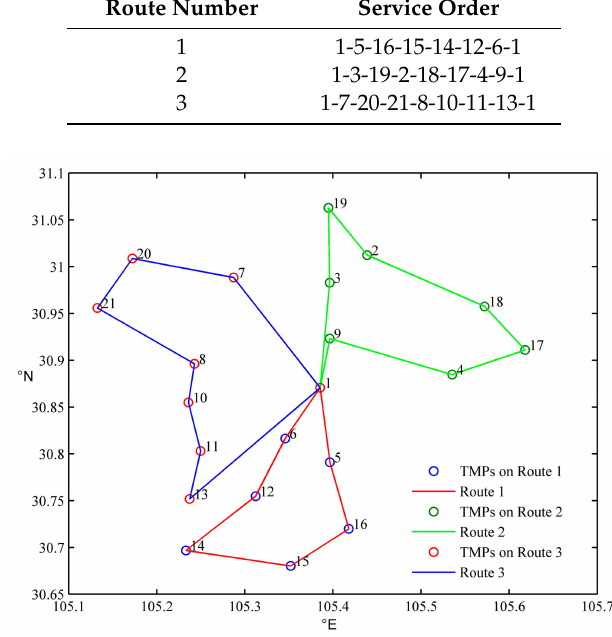
Table 5. The initial distribution service order.